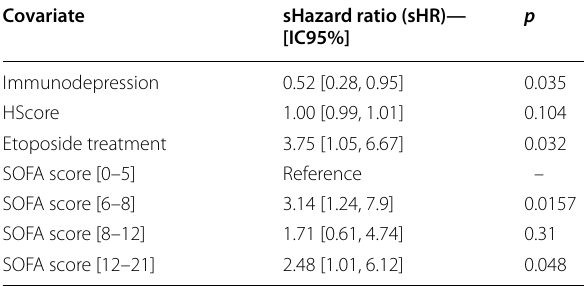
Table 3 Factors associated with the incidence of HAI (Fine and Gray proportional hazards model for competing events)